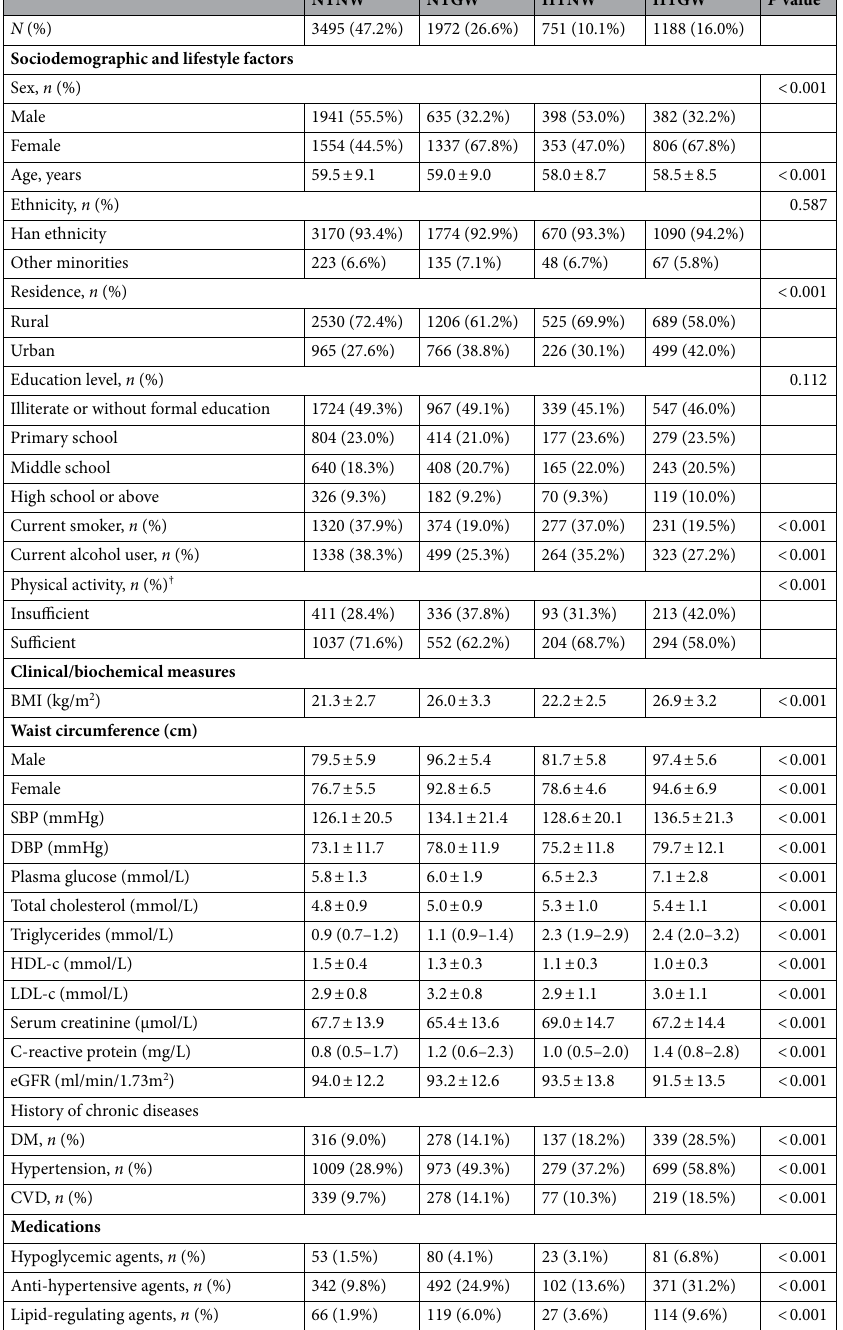
Table 1. Comparison of baseline characteristics according to different triglyceridemic-waist phenotypes. NTNW normal triglyceride levels and normal waist circumference, NTGW normal triglyceride levels with enlarged waist circumference, HTNW high triglyceride levels and normal waist circumference, HTGW high triglyceride levels and enlarged waist circumference, BMI body mass index, SBP systolic blood pressure, DBP diastolic blood pressure, HDL‑c high-density lipoprotein cholesterol, LDL‑c low-density lipoprotein cholesterol, eGFR estimated glomerular filtration rate, DM diabetes mellitus, CVD cardiovascular disease. † Physical activity was only available for 3,140